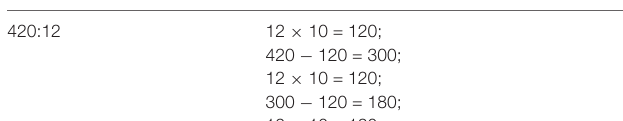
TABLE 3 | Example for division using